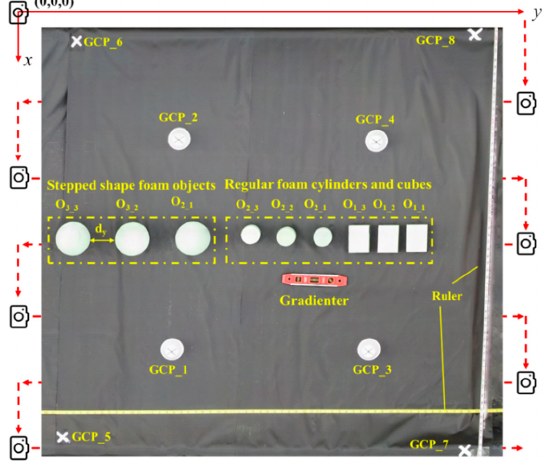
Figure 2. Illustration of experimental setup and imaging pattern.